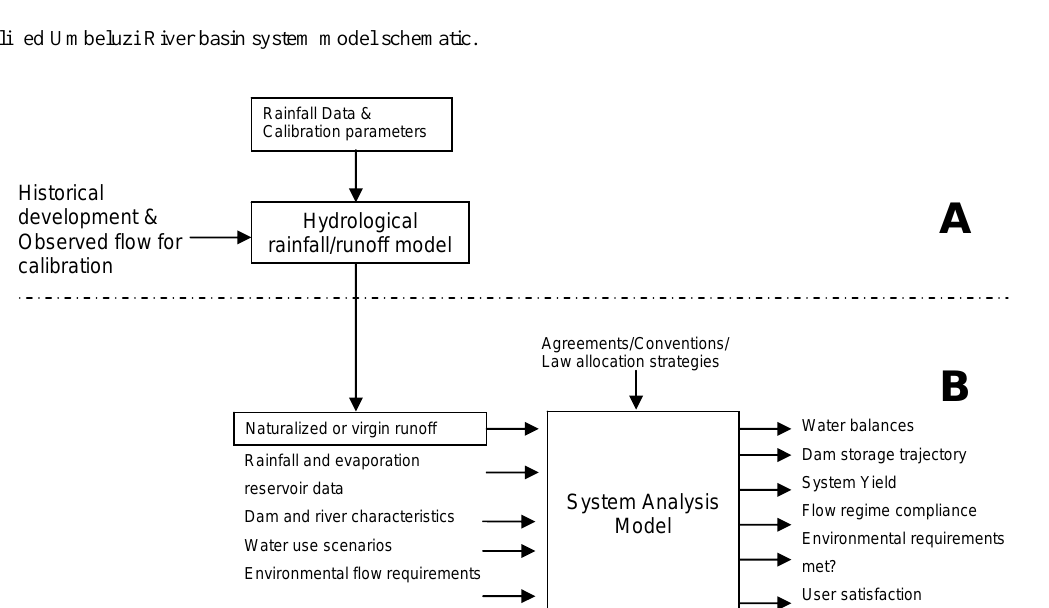
Fig. 3. Modeling for water resources allocation in international rivers. (A) and (B) denote the two steps normally used to obtain the Modeling for water resources allocation in international rivers. A & B denote the two steps normally used information for water to obtain the information for water allocation